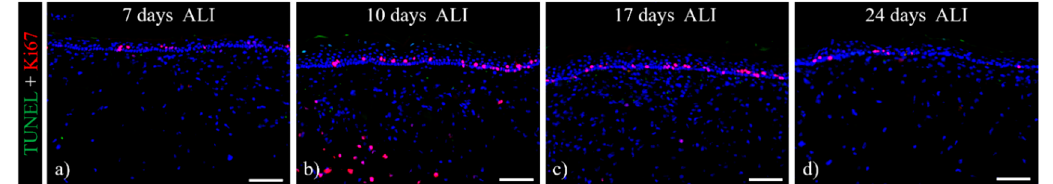
Figure 9. TUNEL-Ki67 stain of ftSEs. TUNEL-positive apoptotic cells are stained in green, and proliferative Ki67 positive cells are stained in red. A considerable number of proliferating cells within the basal layer of the ftSEs and a few apoptotic cells are found after ( a ) 7, ( b ) 10, ( c ) 17 and ( d ) 24 days of ALI cultivation. Counterstaining of cell nuclei with DAPI (blue). Scale bar: 100 μ m.